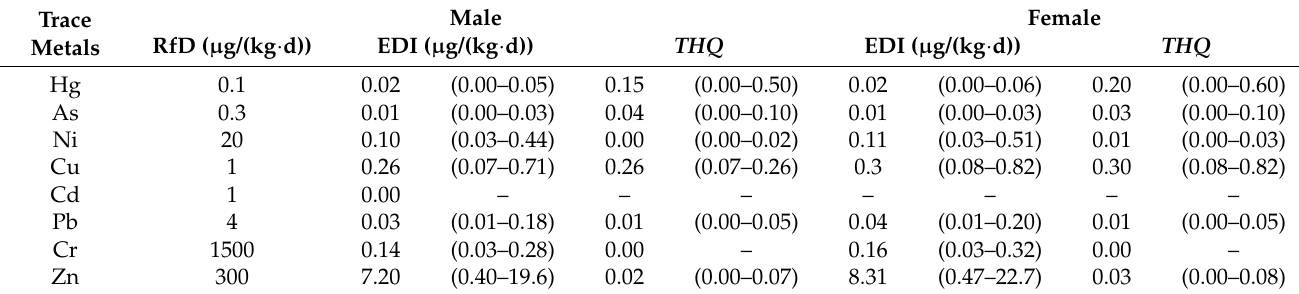
Table 5. THQ for males and females of the fish species considered in this study.